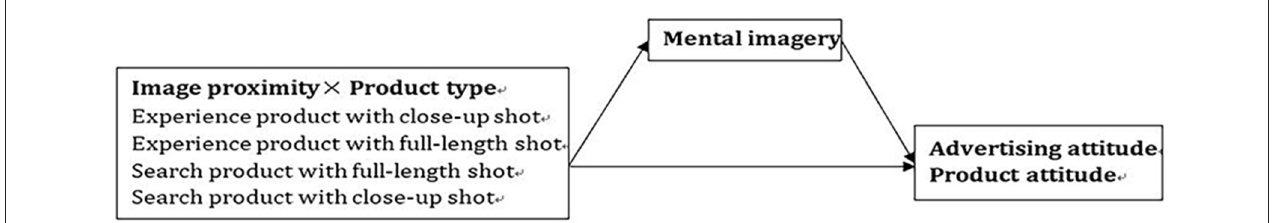
FIGURE 1 | Research